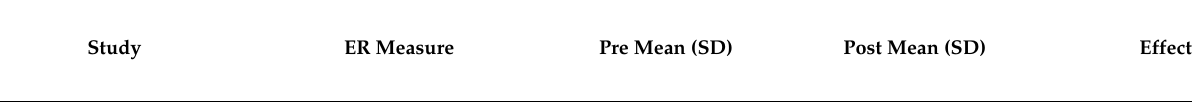
Table 2. Summary of treatment effects on ER outcome